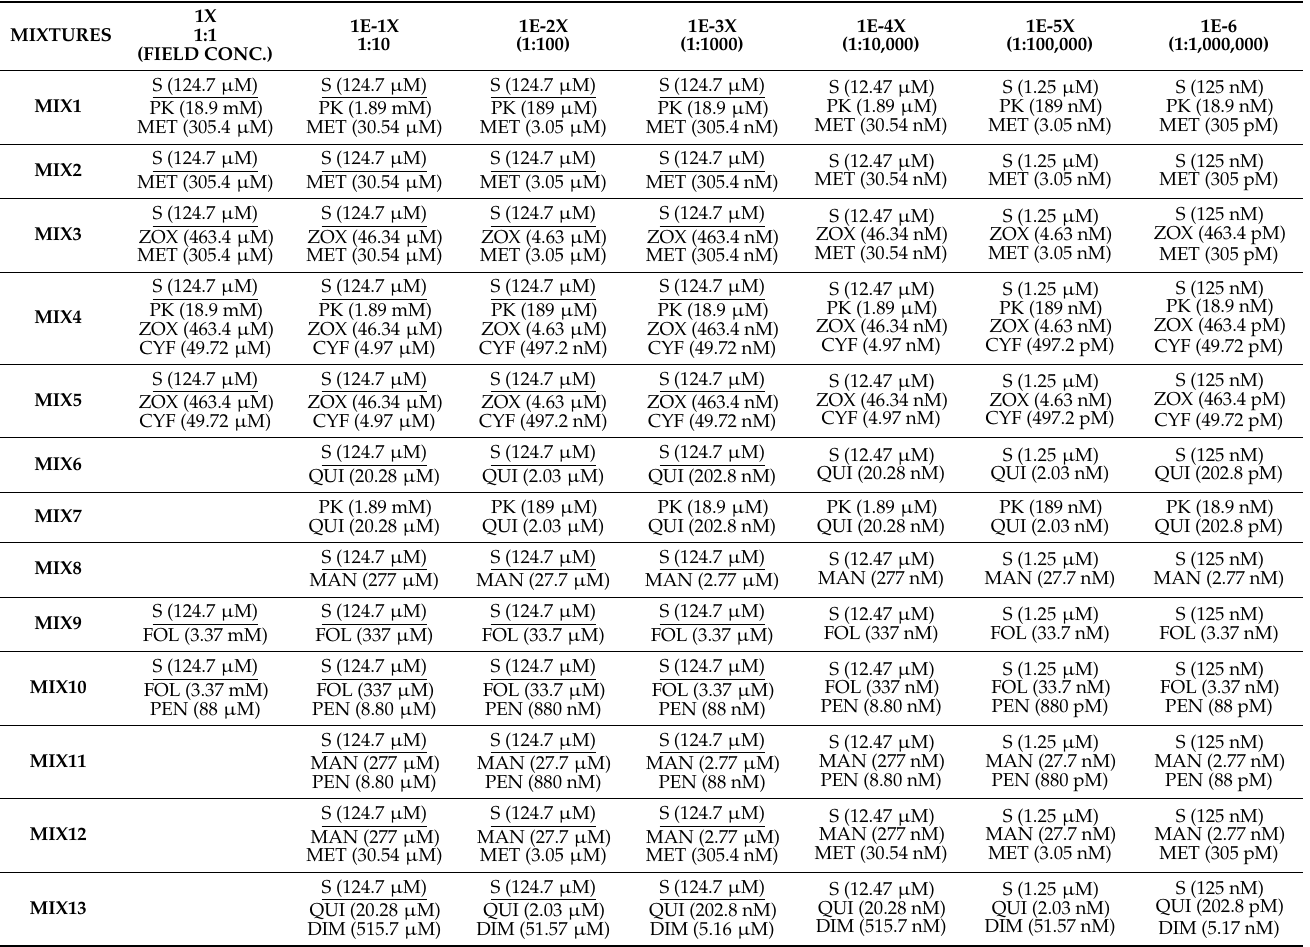
Table 1. Composition of the 13 pesticide mixtures. Serial dilutions of field concentrations and corresponding nominal concentrations of each active compound are